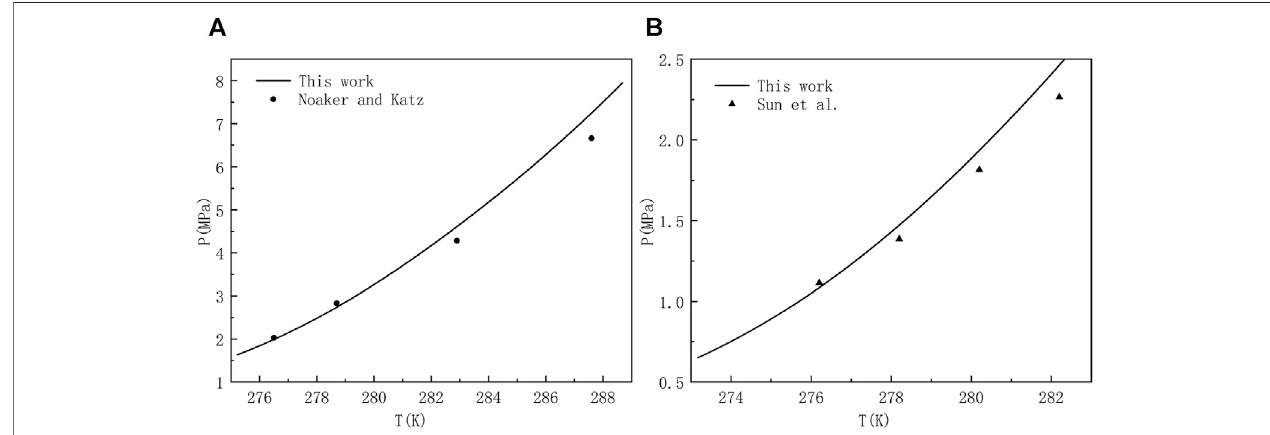
FIGURE 4 | Estimated and experimental hydrate equilibrium pressures for a system of (A) 96.89 mol% methane and 3.11 mol% hydrogen sulfate (Noaker and Katz, 1954), and (B) 82.45 mol% methane, 10.77 mol% carbon dioxide, and 6.78 mol% hydrogen sulfate (Sun and Chen,